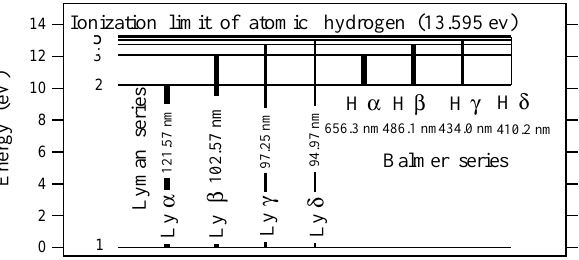
Fig. 2. Energy level diagram for atomic